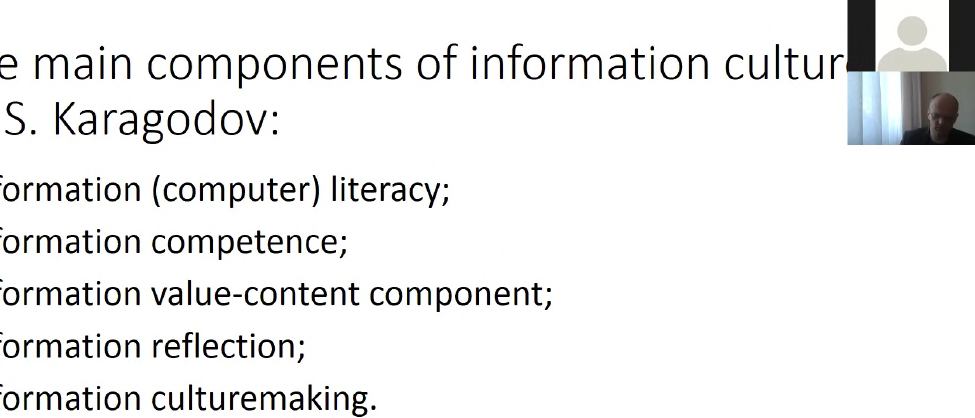
Figure 49: Presentation of paper [327].